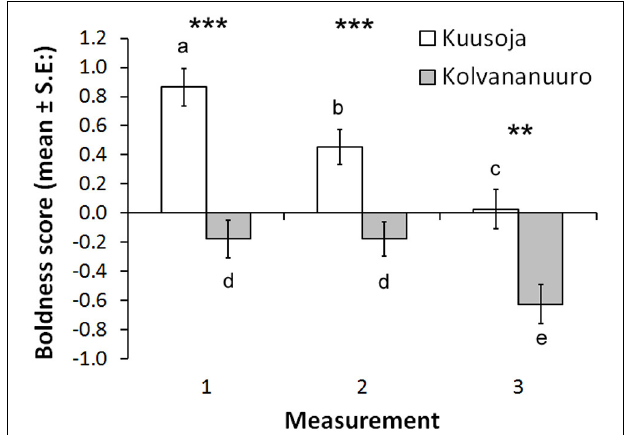
FIGURE 4 | Estimated marginal means for activity scores in the three behavioral trials in the two study populations (Kuusoja River and Kolvananuuro Brook). None of the paired comparisons (both among sexes within measurements and measurements within sexes) were statistically